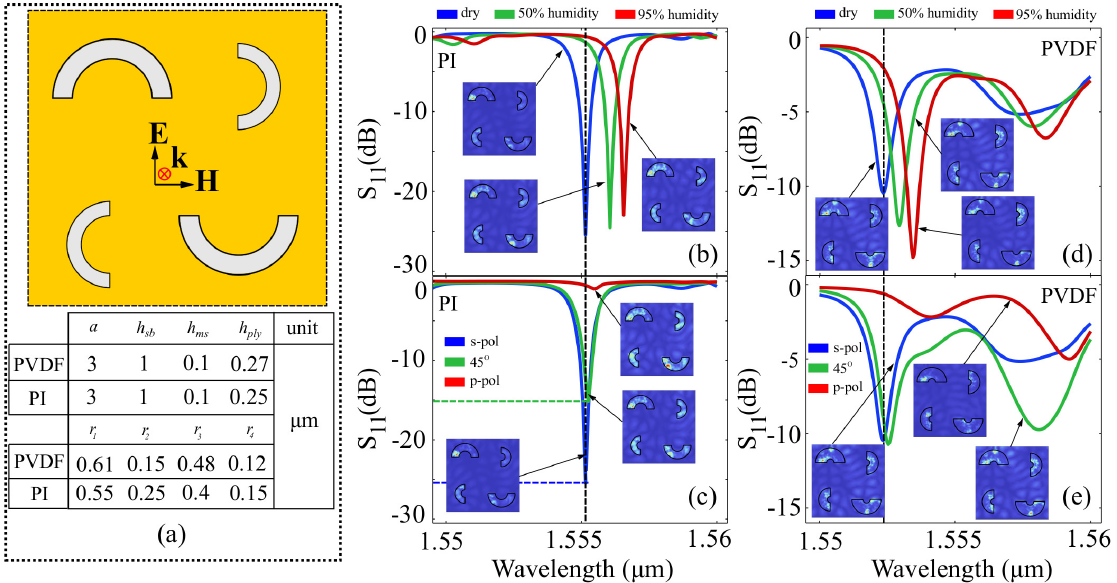
Figure 2. Results obtained for the half-ring structure: ( a ) layout of the ring elements and element sizes chosen for the PVDF and PI in order to have a resonant response around the working wavelength; ( b ) spectral behavior of the PI half-ring element structure at different humidity levels and ( c ) at different input polarization states; and ( d ) spectral behavior of the PVDF half-ring element structure at different humidity levels and ( e ) at different input polarization states. For subfigures ( b – e ), the insets show the local field enhancement in the interface plane taken at maximum